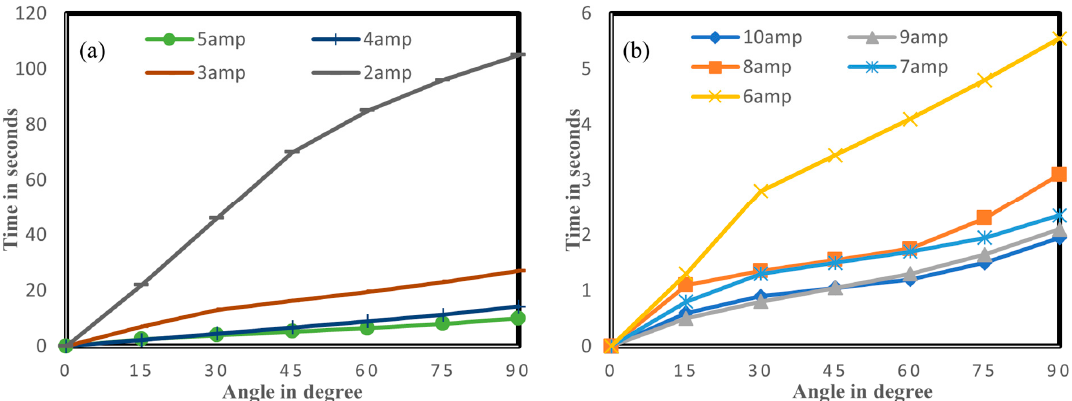
Figure 7. Actuation time vs. angle traveled by the valve for 5 V constant voltage and current of ( a ) 2–5 A and ( b ) 6–10 A.